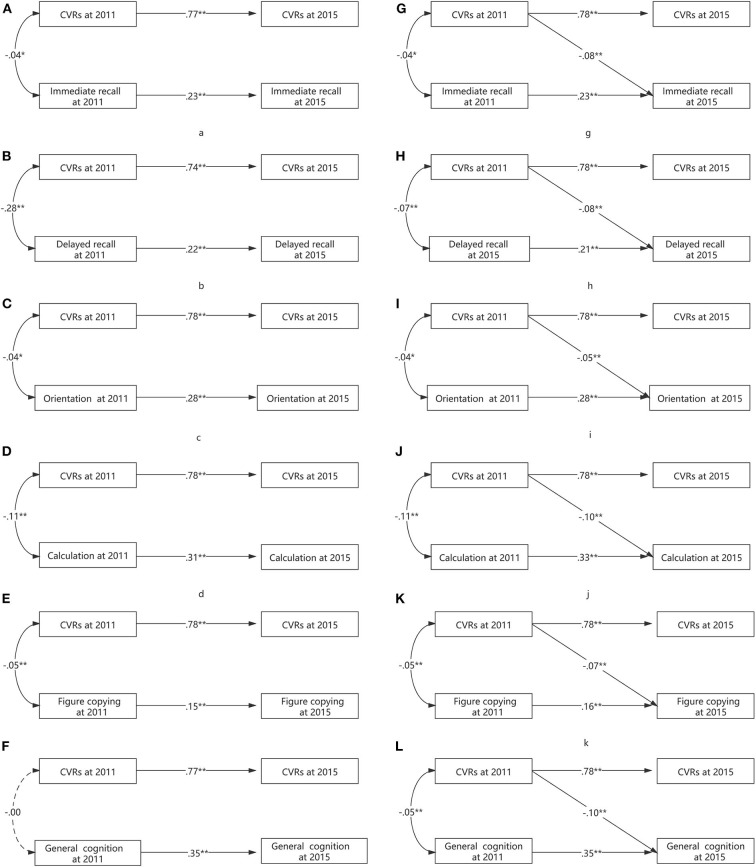
(A–L) The longitudinal association between CVR and cognition.